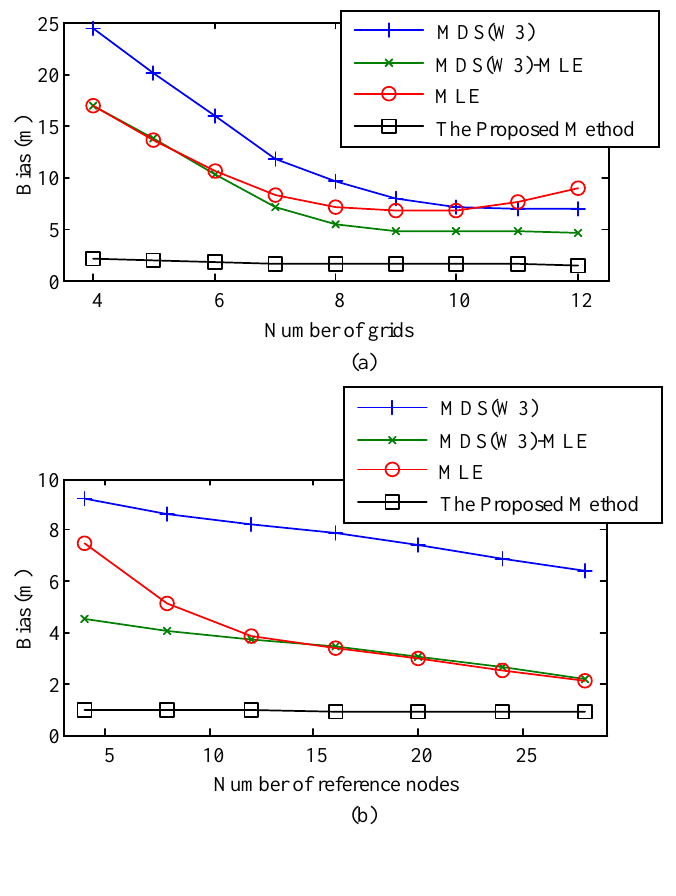
Figure 8. Bias performance of the proposed algorithm and previously proposed methods (a) versus the number of grids and (b) versus the number of reference